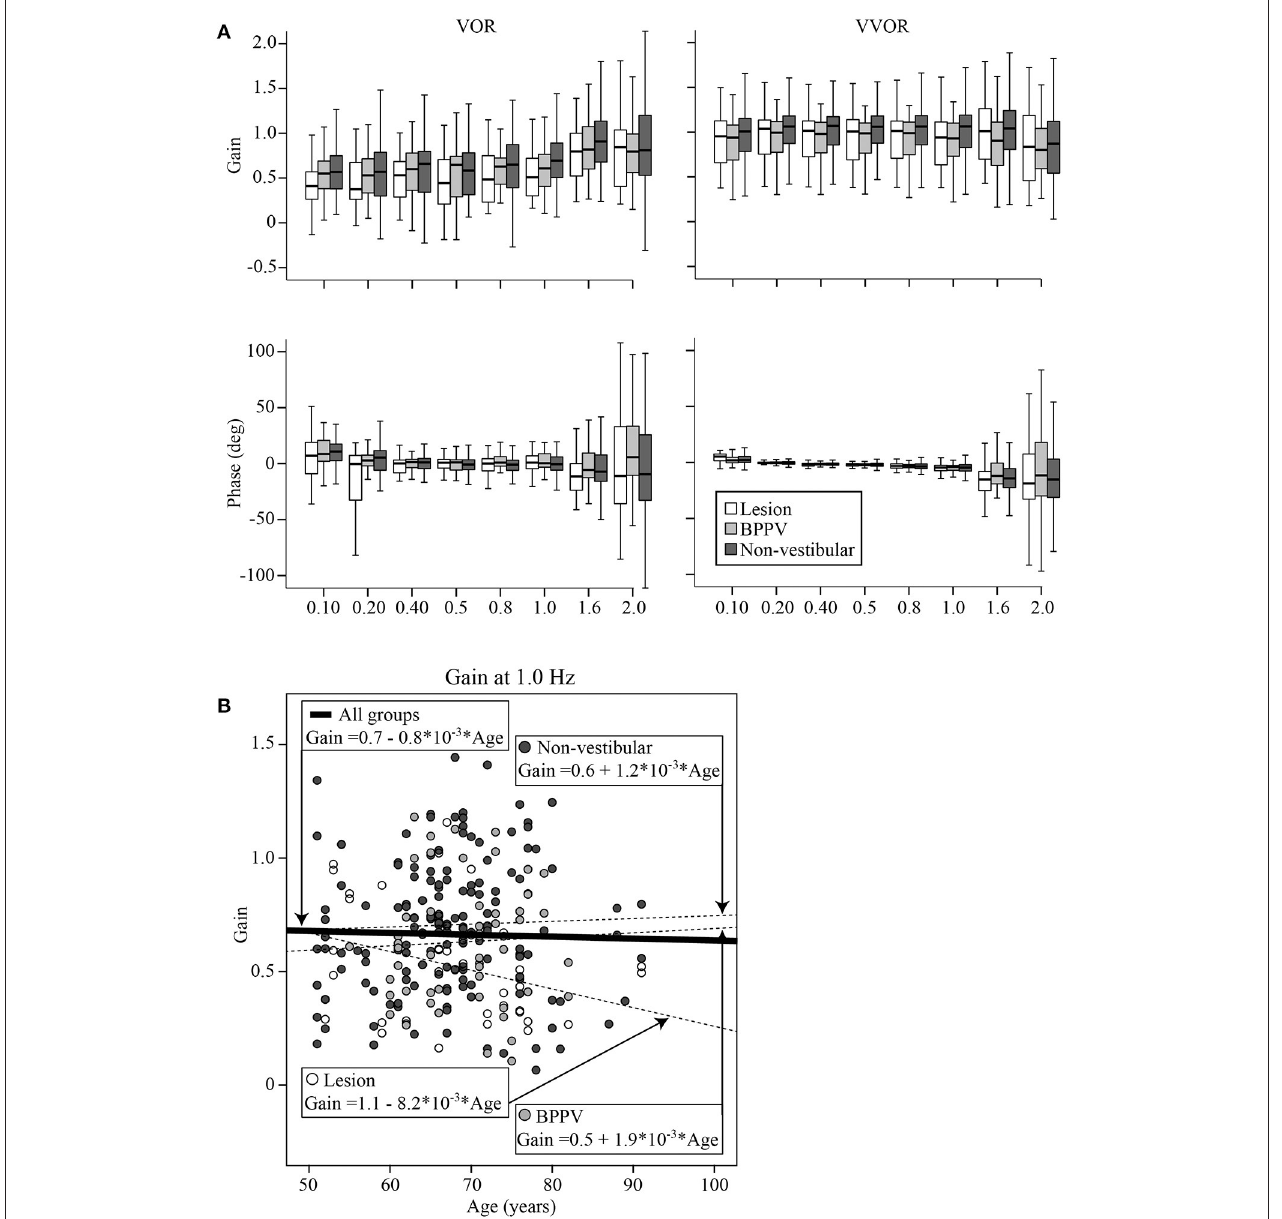
FIGURE 5 | (A) Boxplots of the VOR (left column) and VVOR (right column) gains (top row) and phases (bottom row) across test frequencies for each group (Lesion group in white, BPPV in light gray, and Non-vestibular in dark gray). Each box begins at the first quartile, ends at the third quartile, denotes the median with a horizontal stripe and has whiskers denoting the maximum and minimum values. (B) VOR gain at 1Hz for each participant vs. their age, clustered by group with group and overall line-fits. 7.9 ± 4.1, 9.4 ± 3.8, and 9.6 ± 5.4 s. Linear regression